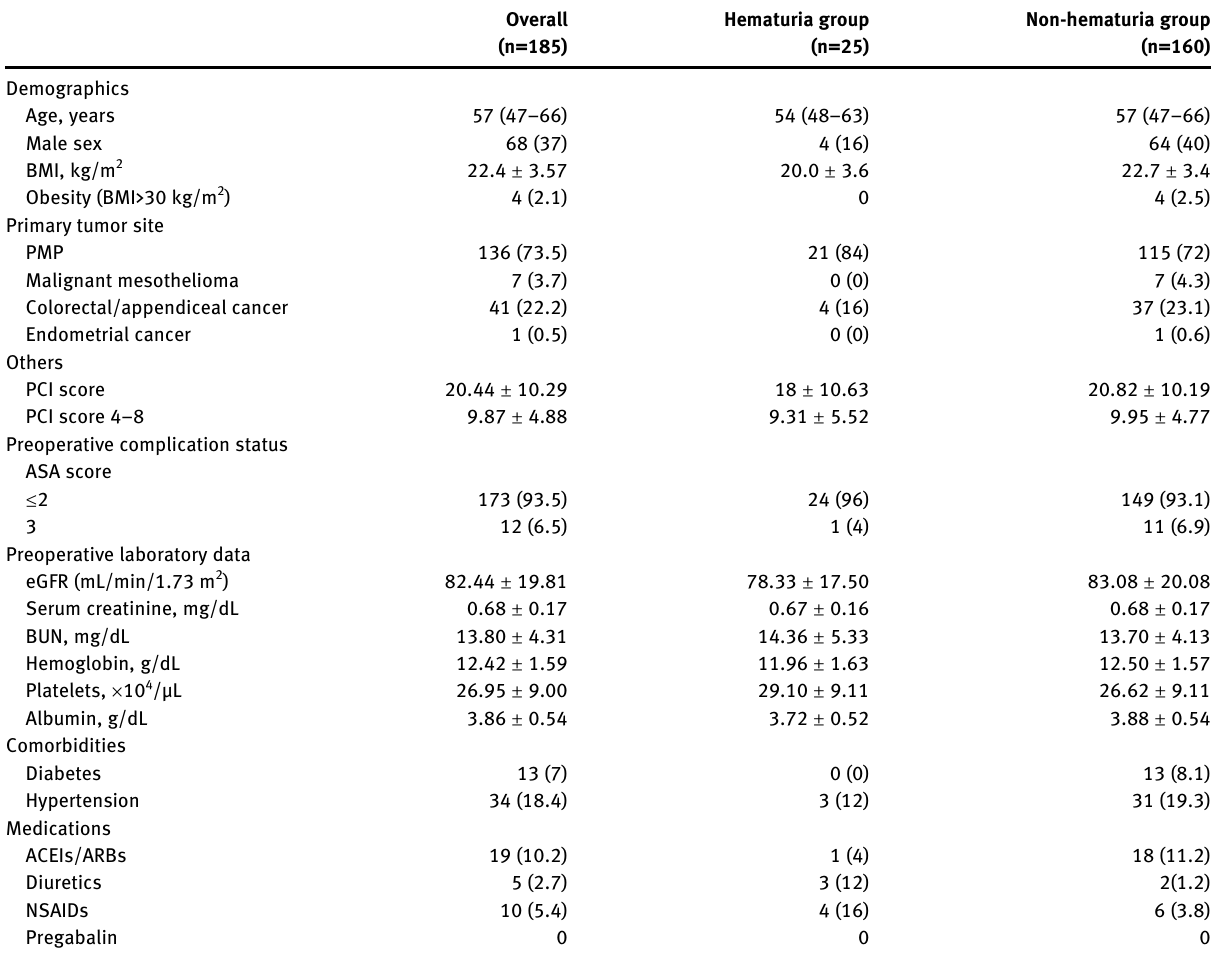
Table  : Baseline characteristics of participants.